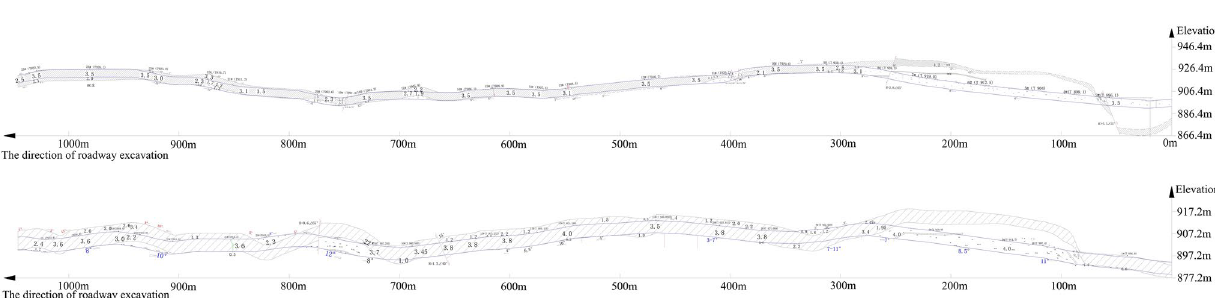
Figure 3. Contour of coal seam floor of 80,207 working face (plotted by borehole data of the minefield).